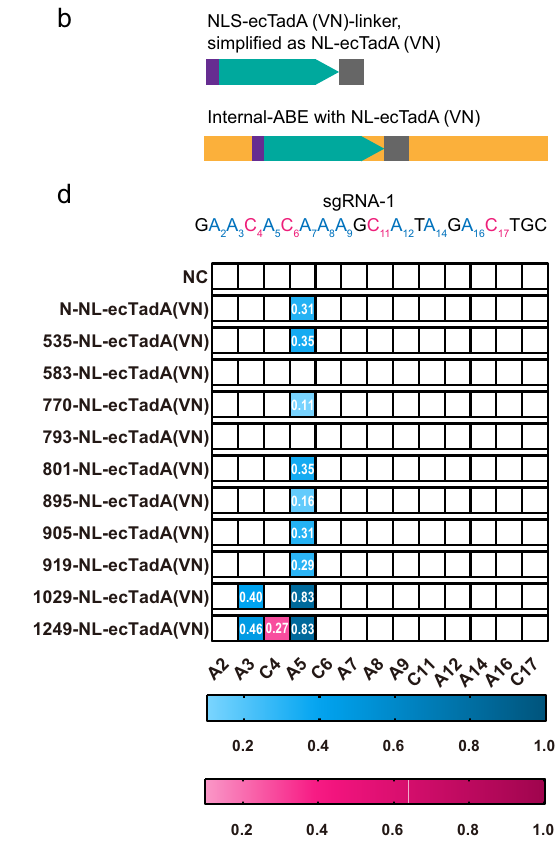
Fig. 1 | Editing capacity of ecTadA(VN)-derived ABEs. a , b Illustration of ecTa- dA(VN) and – derived ABE structures generated via internal insertion strategy. c , d The editing frequencies are shown in heatmap format, with adenine editing ef fi ciencies (A-to-G editing) shownin blue and cytosine editingef fi ciencies (C-to-T editing) in pink gradient color. Engineered ABEs were generated in combination with internal insertion with ecTadA(VN) ( c ) or NLS-ecTadA(VN)-linker (NL-